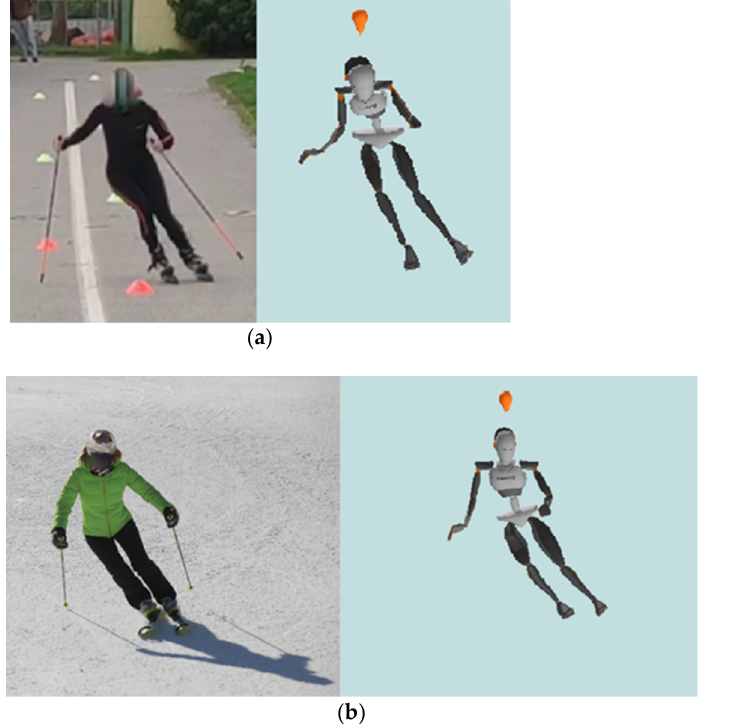
Figure 1. ( a ) Preview of IS turn; ( b ) preview of AS turn.